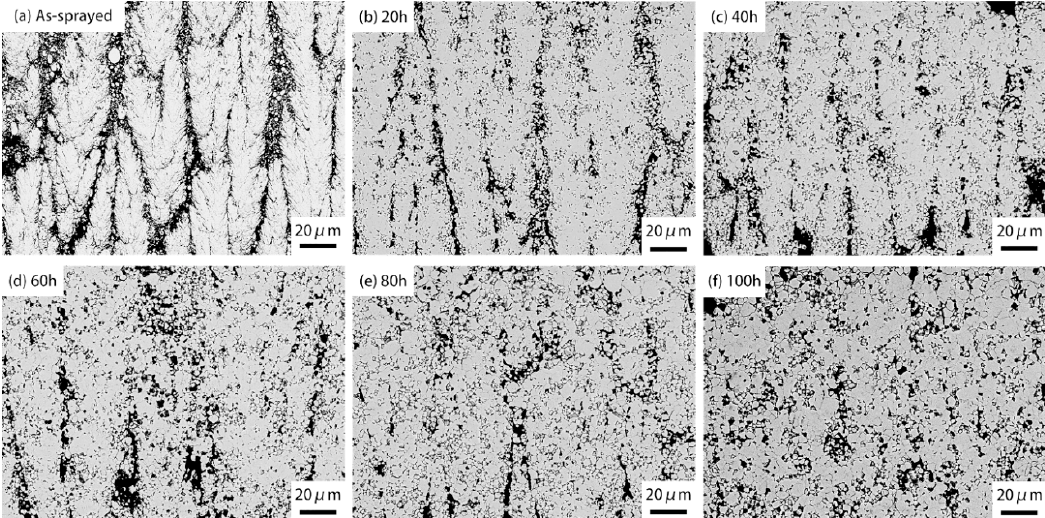
Figure 6. SEM micrographs of polished cross-sections of PS–PVD coatings as a function of time: ( a ) as-sprayed; ( b ) 20 h; ( c ) 40 h; ( d ) 60 h; ( e ) 80 h; and ( f ) 100 h.